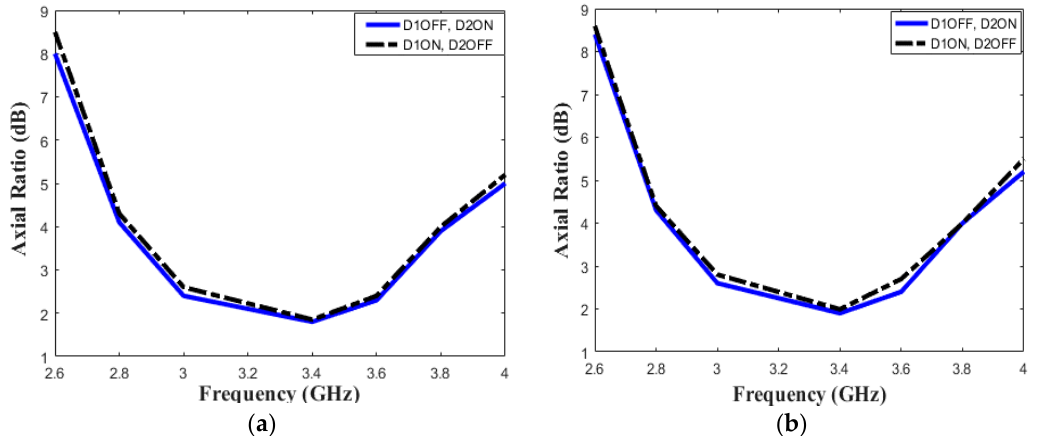
Figure 8. Axial ratios for the proposed reconfigurable antenna: ( a ) Simulation results; ( b ) Measurement results.